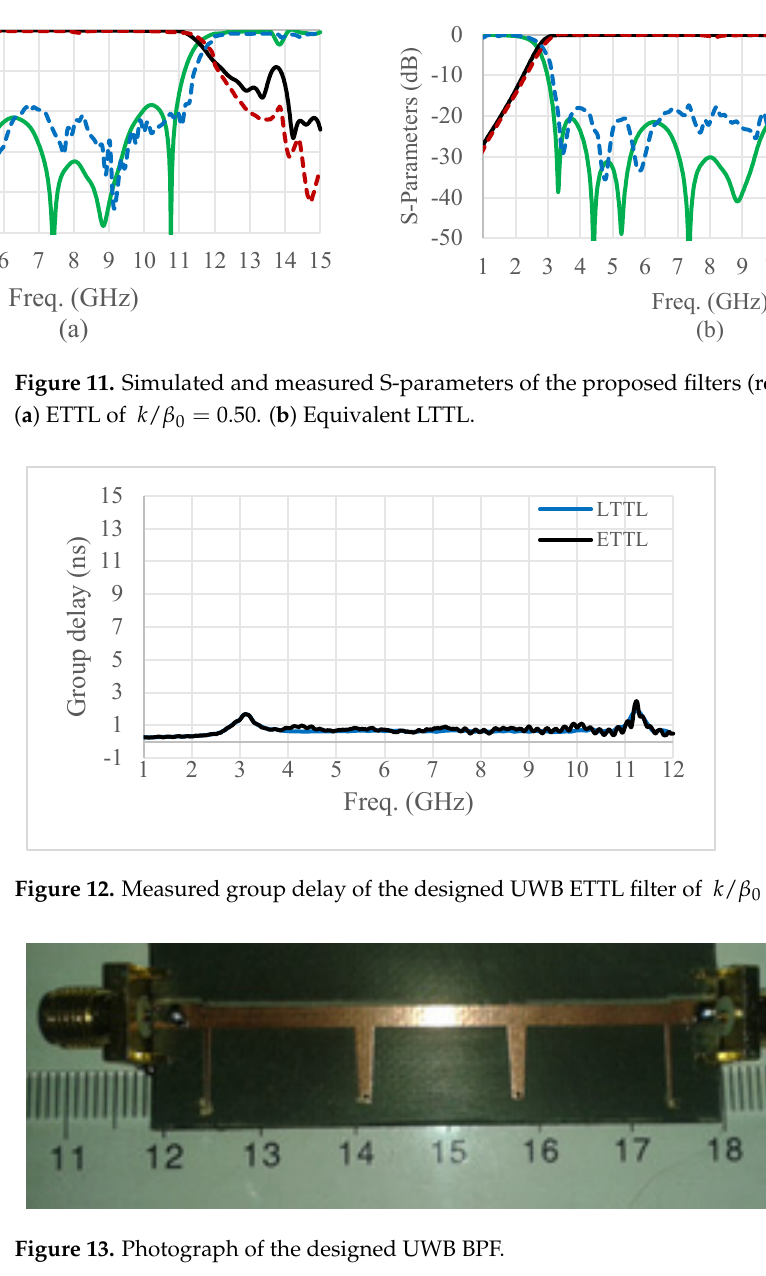
Table 4. Performance comparison with other UWB filter techniques.